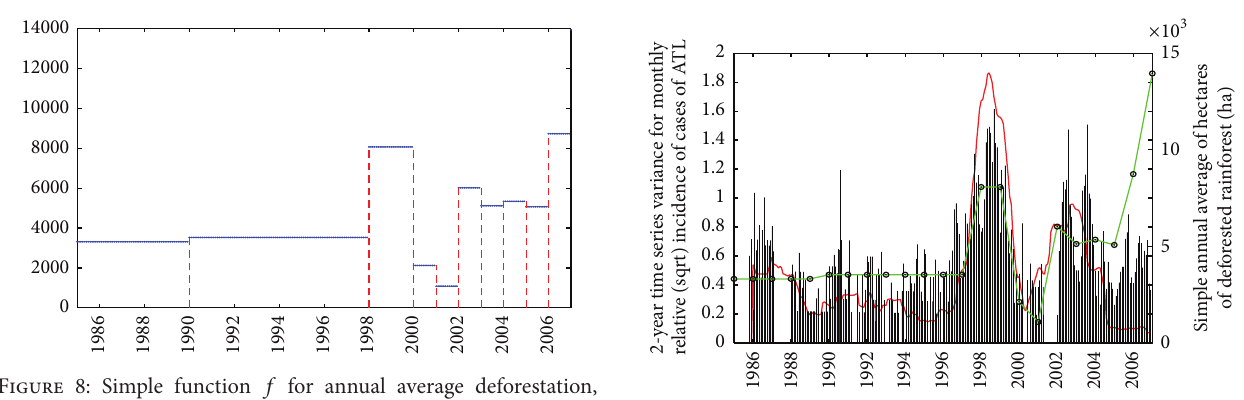
Figure 8: Simple function 𝑓 for annual average deforestation, cleared hectares of forest in Department of Or´an, Salta, Argentina, period 1985–2007.